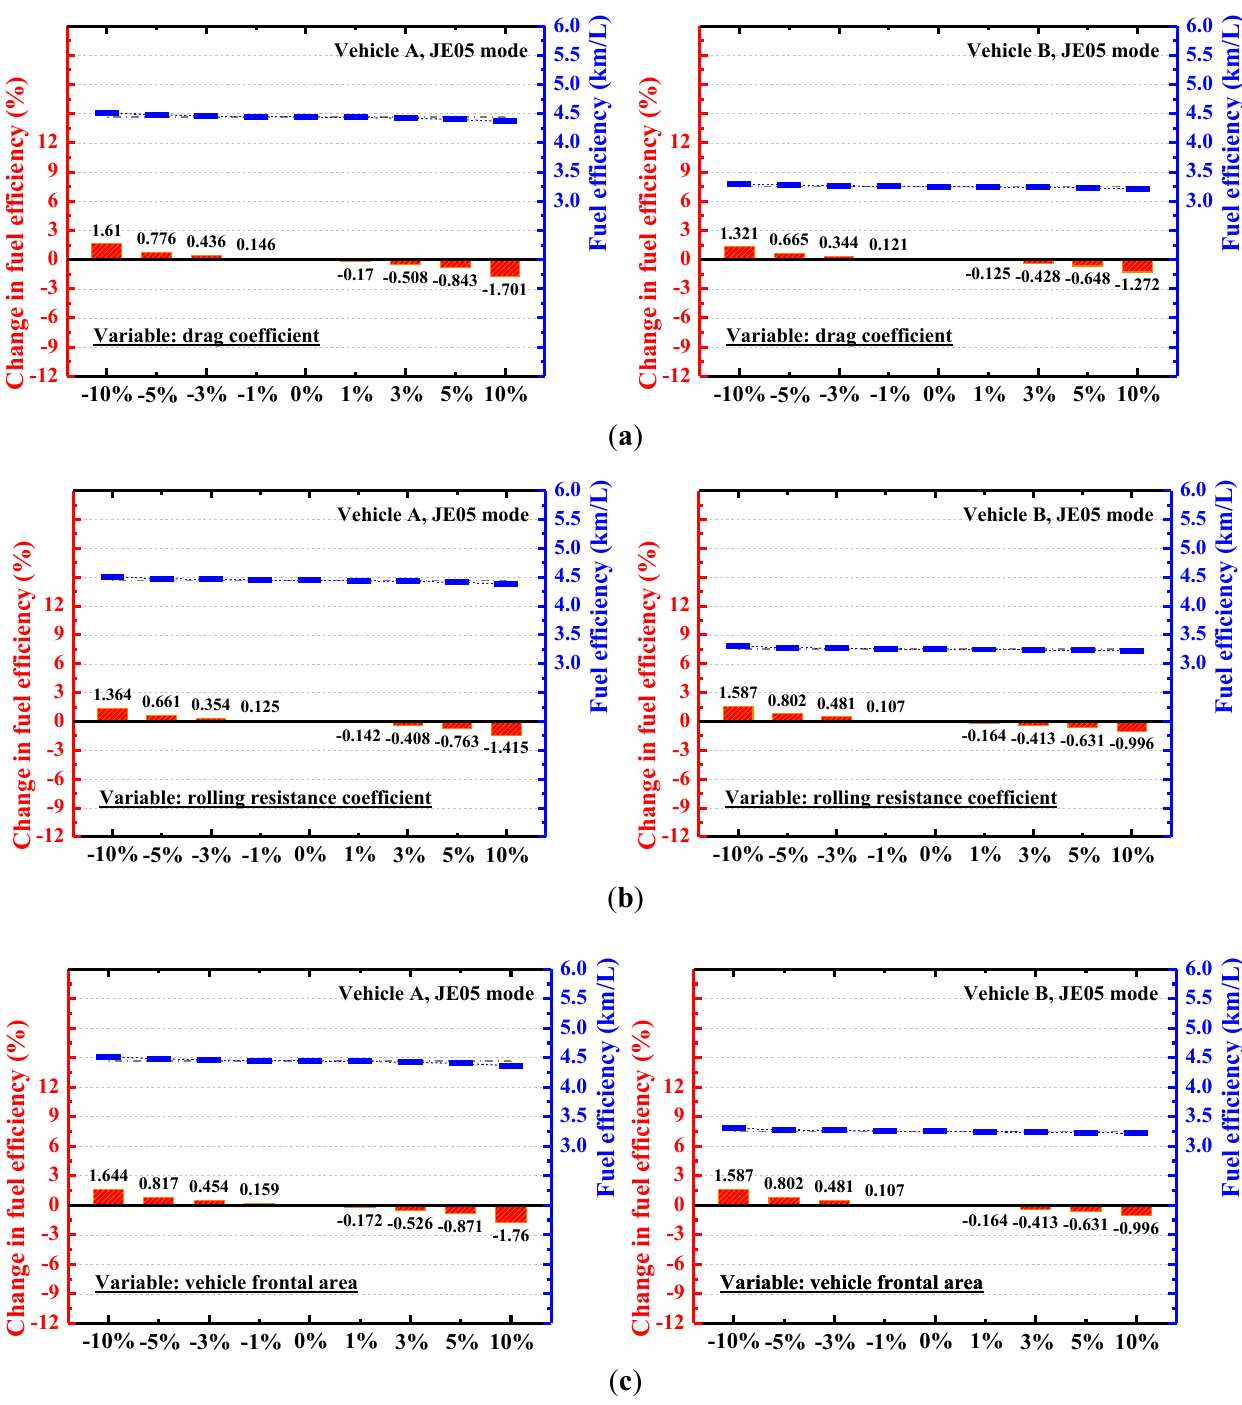
Figure 15. Change of the predicted fuel efficiency results with variation of the drag resistance, rolling resistance and frontal area of HDV: ( a ) drag coefficient ( b ) rolling resistance coefficient ( c ) vehicle frontal